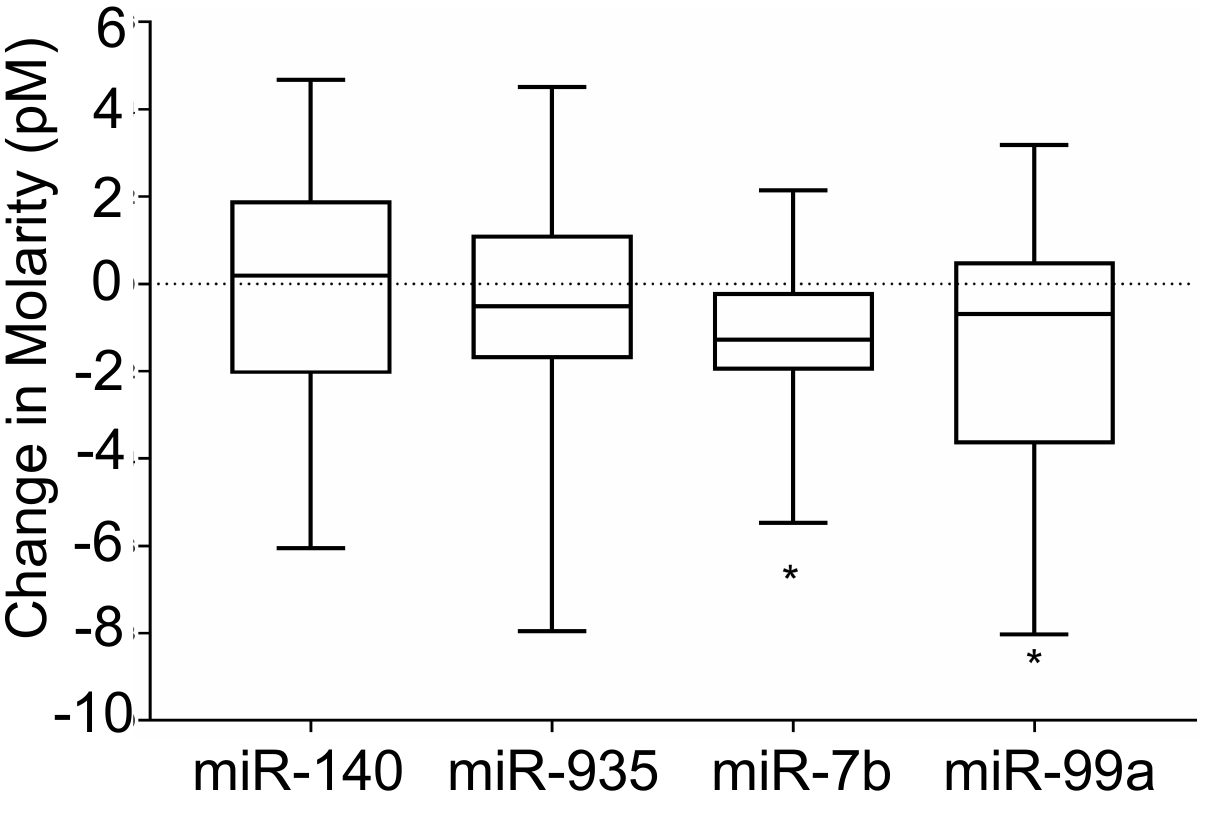
Figure 4. Variation of miRs-140, -935, -let-7b, and -99a, during the diet and exercise intervention. The change in molarity (post-pre) values were calculated. Molarity values were calculated using iLluminate for each miR target * p < 0.05. Table 2. Responders and non-responders to the 6 week diet and exercise